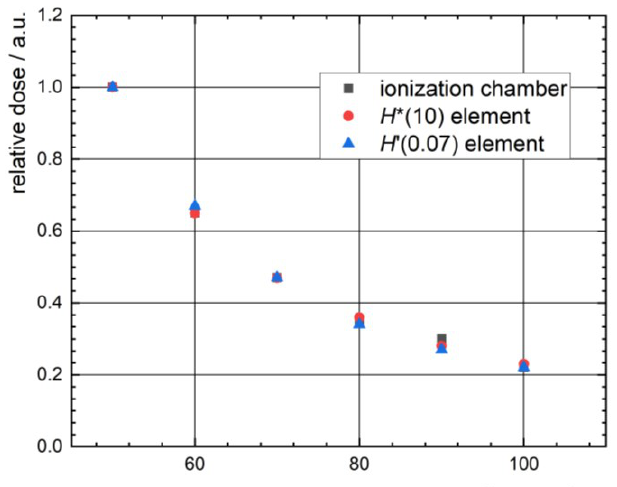
Figure 7. The relative dose decreases with greater distances. The black values belong to the reference measurement with an ionization chamber (UNIDOS webline), the red to the H *(10) element and the blue to the H ´(0.07) element of the detection system. All measured values are normalized to the respective first value recorded at a distance of 50